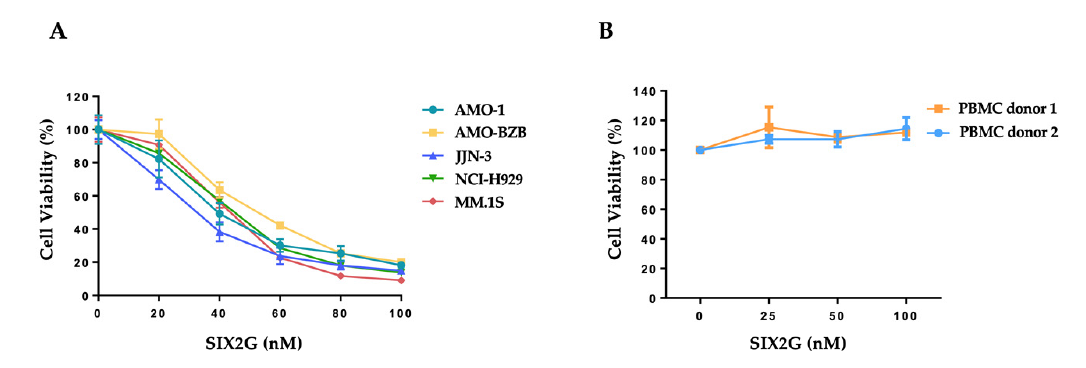
Figure 3. Dose-response curves. CellTiter-Glo ® Luminescent Cell Viability assay was conducted on tumoral MM cell lines ( A ) and on PBMC from healthy donors ( B ) 48 h after treatment with SIX2G at the indicated concentrations. Dose-response curves represent the percentage (%) of cell viability ± standard deviation (SD) of treated cells. Absorbance values were normalized on values from DMSO treated cells (vehicle) to calculate the represented